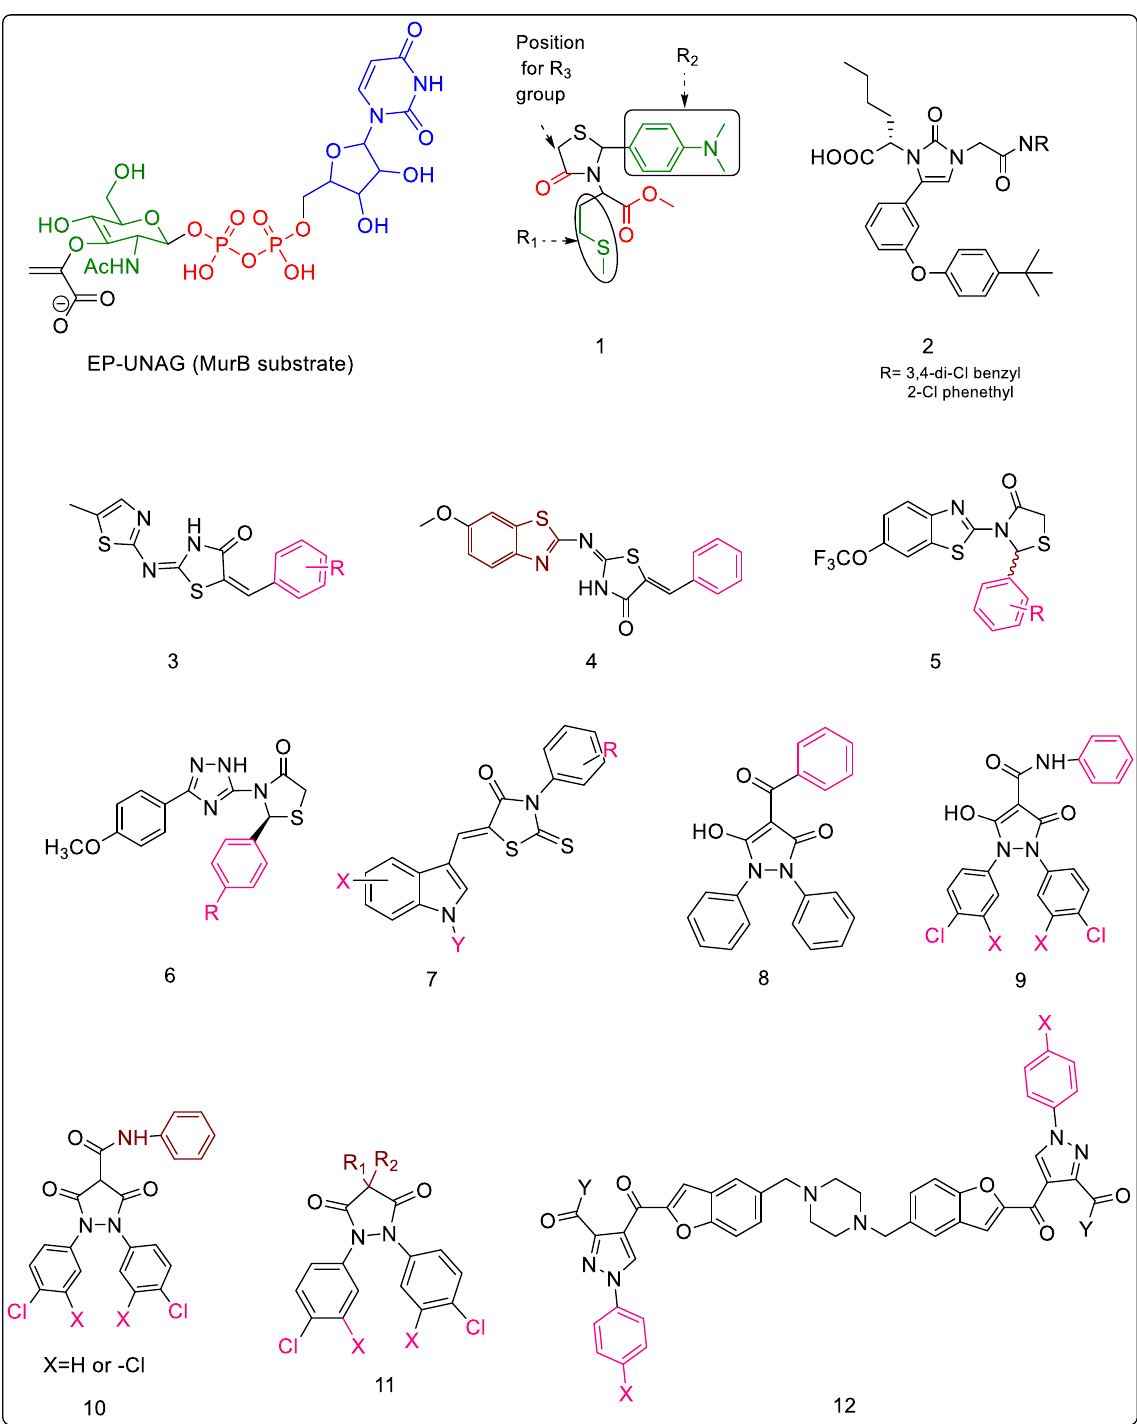
Figure 2. Structural classes of Mur B substrates. ( 1 ) Substituted-4-thiazolidinone; ( 2 ) imidazolinones; ( 3 ) 5-Benzylidene-2-thiazolyimino-4-thiazolidinones; ( 4 ) benzylidene benzothiazolo thiazolidinones derivative; ( 5 ) benzothiazole-based thiazolidinones; ( 6 ) triazole-based thiazolidinones; ( 7 ) 5-Indolylmethylen-4-oxo-2-thioxothiazolidines; ( 8 ) 5-Hydroxy-1H-pyrazol-3(2H)-one; ( 9 ) 5-Hydroxy-1H-pyrazol-3(2H)-one carboxamide derivatives; ( 10 ) 3,5-Dioxopyrazolidines; ( 11 ) 4-substituted 1,2-bis(4-chlorophenyl) pyrazolidine-3,5-diones; ( 12 ) bis(pyrazole-benzofuran) hybrids containing piperazine linker.